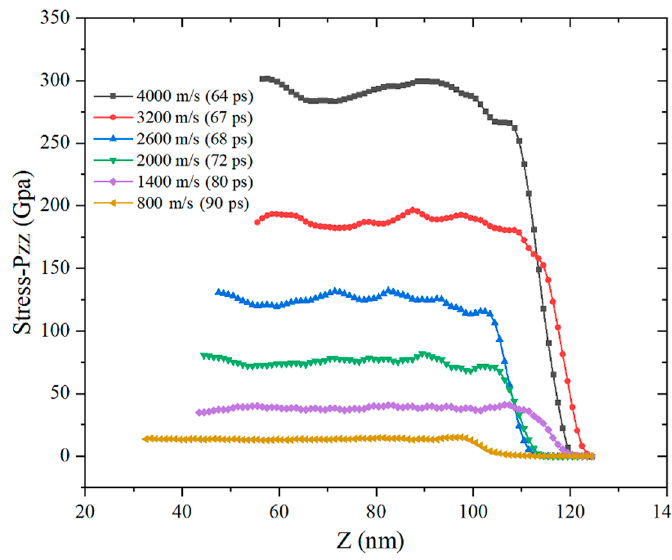
Figure 16. Stress waveforms at different impact speeds.